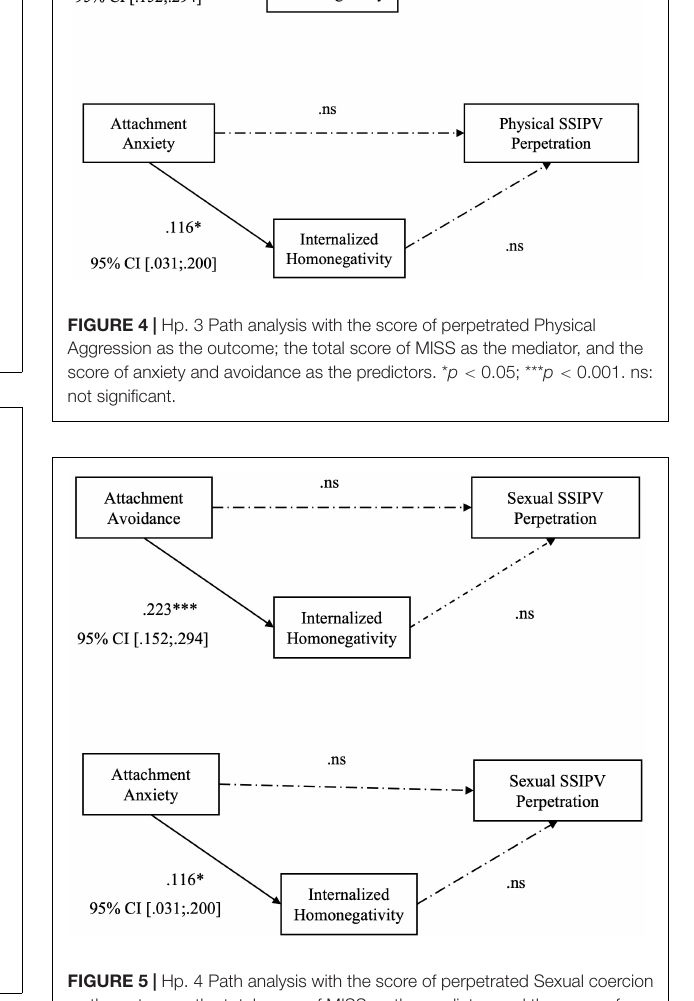
FIGURE 5 | Hp. 4 Path analysis with the score of perpetrated Sexual coercion as the outcome, the total score of MISS as the mediator, and the score of anxiety and avoidance as the predictors. * p < 0.05; *** p < 0.001. ns: not